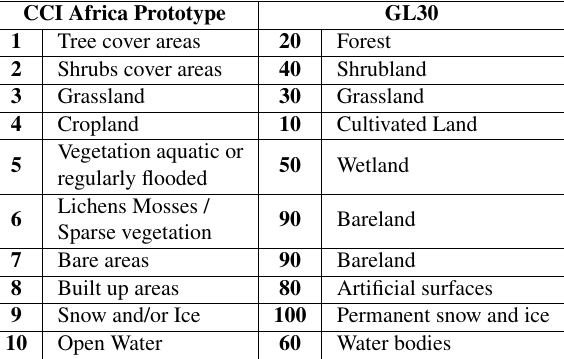
Table 3. Link between the classes of CCI Africa Prototype and